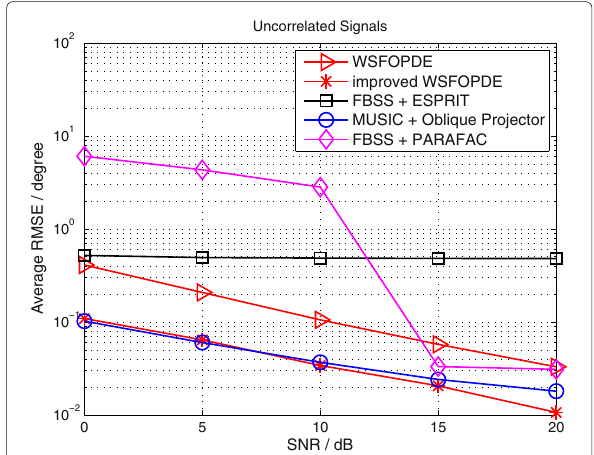
Fig. 1 The performance comparison of DOA-DOD estimation between several typical algorithms: uncorrelated signals